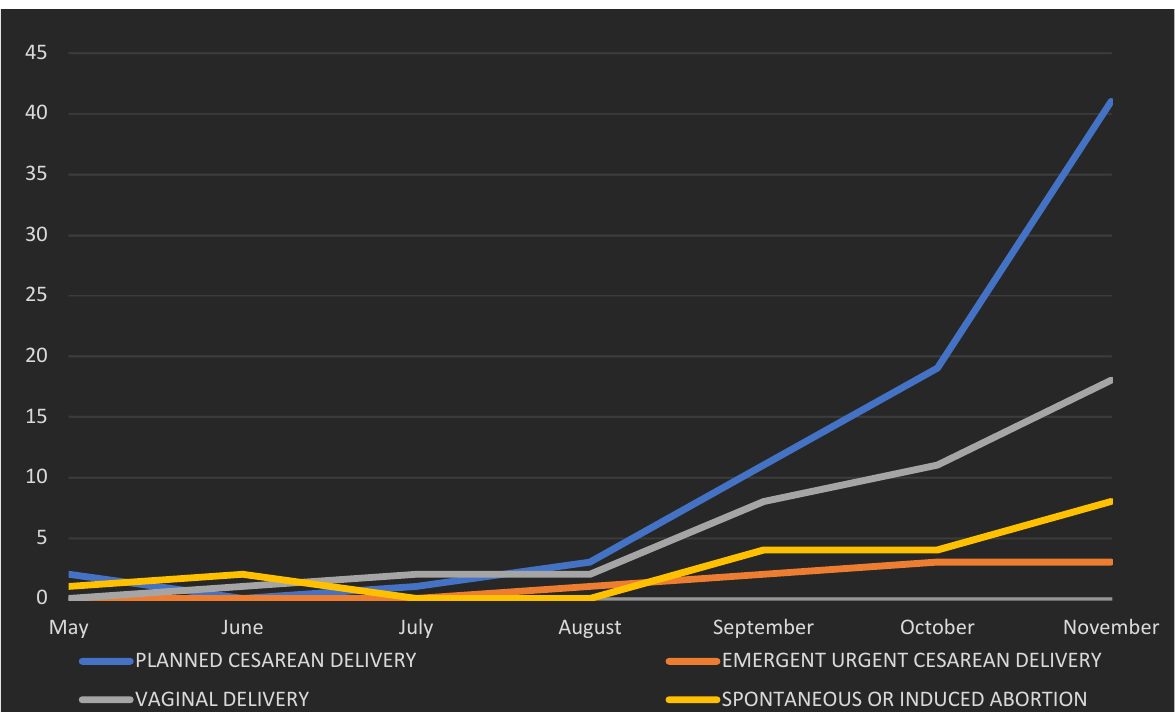
Figure 1. Temporal distribution of cases in the period from May to November 2020.